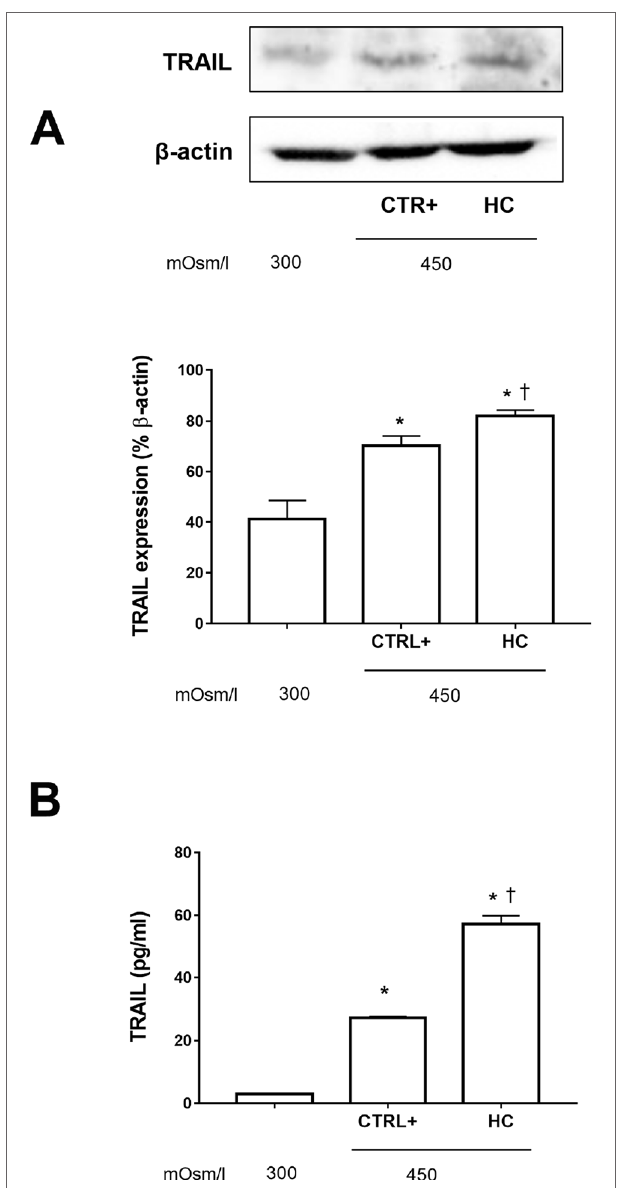
FIGURE 2 | TRAIL levels in SIRCs exposed to hyperosmotic stress. (A) Western-blot analysis of SIRCs lysates for TRAIL expression. (B) ELISA quantification of TRAIL in SIRCs medium. *p < 0.05 vs. SIRCs growth in medium 300 mOsm, † p < 0.05 vs. CTRL+ (SIRCs with hyperosmotic insult); SIRCs, rabbit corneal epithelial cells; HC, hydrocortisone; n = 6.